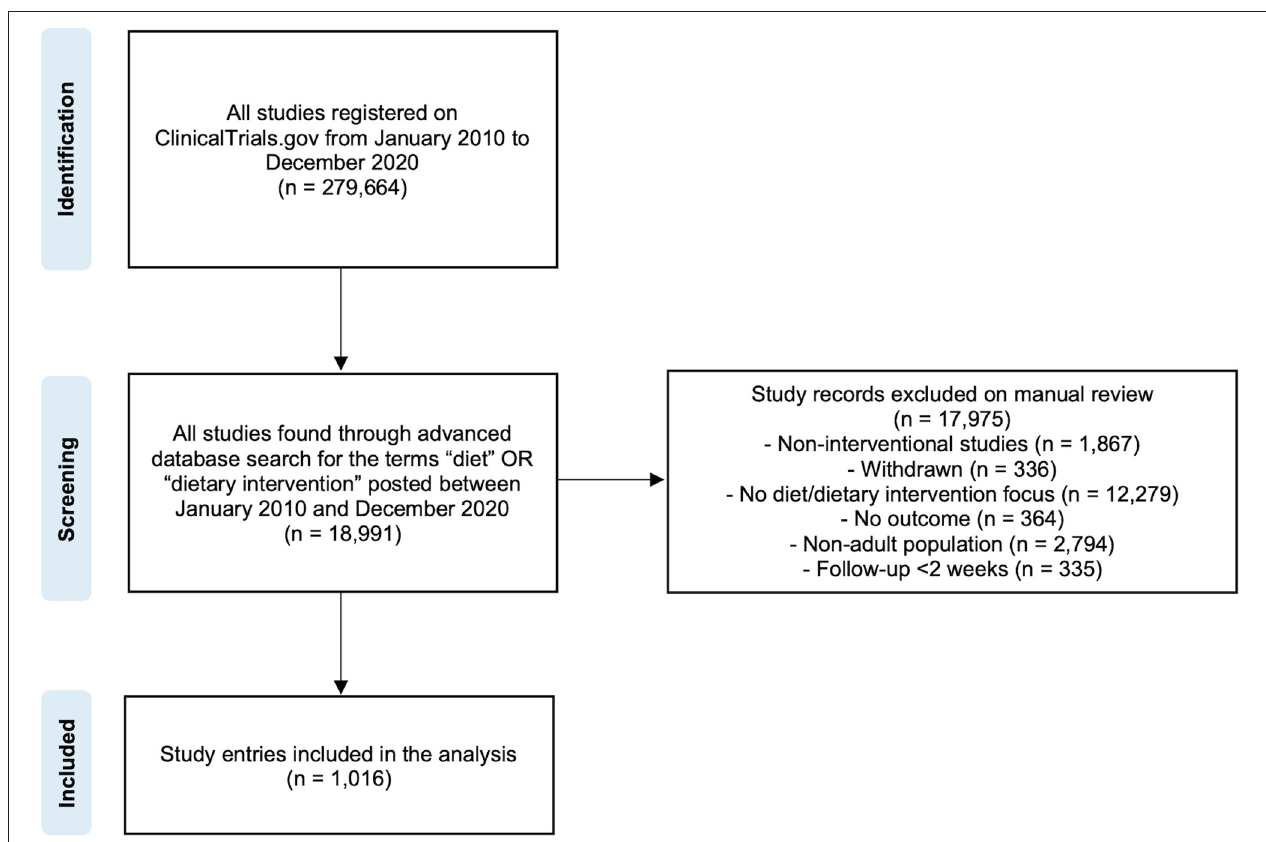
FIGURE 1 | Flowchart for the selection procedure of diet- and health-related clinical study entries considered for the